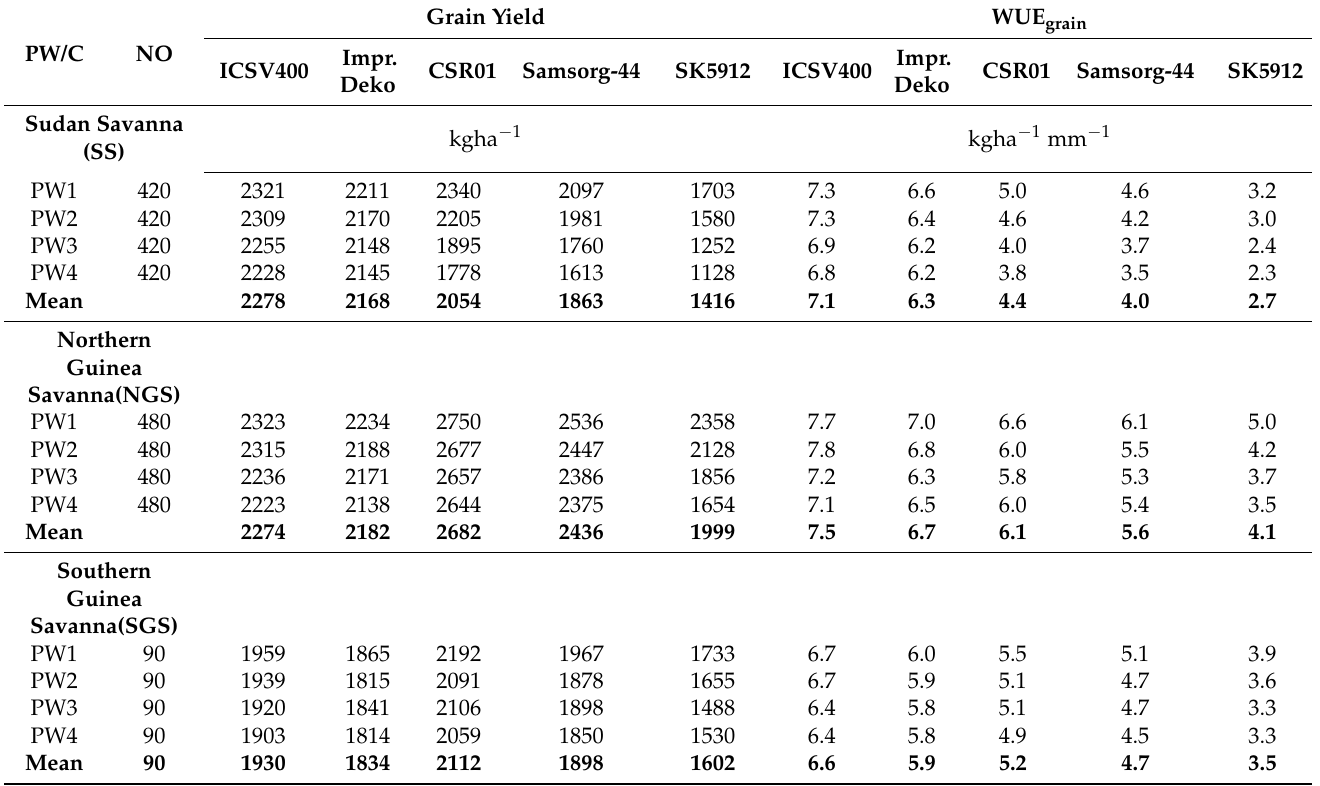
Table 9. Mean simulated grain yield and Water Use Efficiency for grain yield (WUE grain ) of sorghum cultivars across different planting windows (PWs) and agro ecological